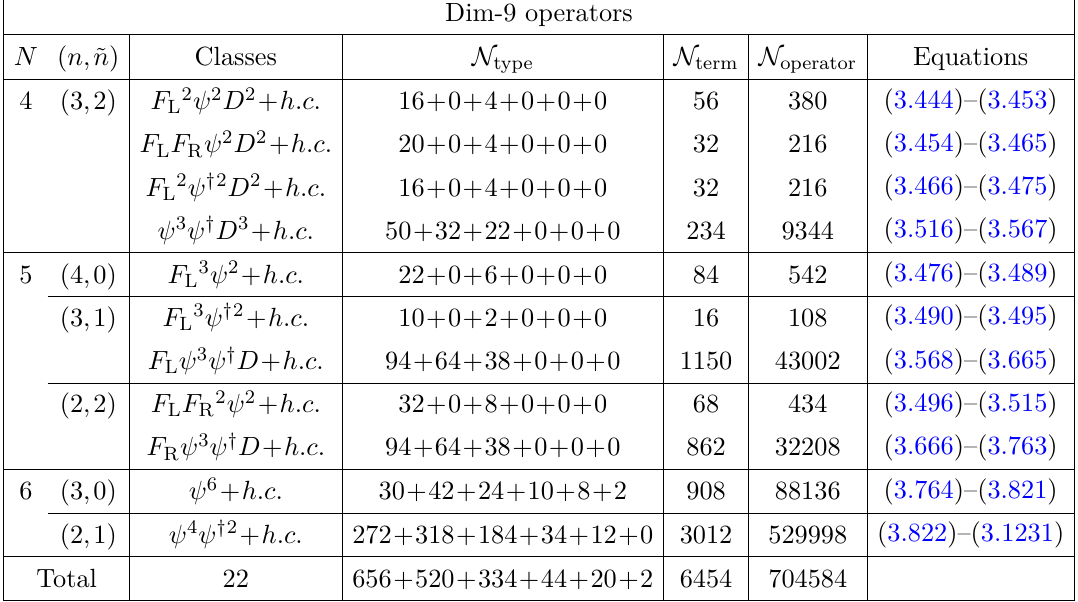
Table 3 . The complete statistics of dimension 9 LEFT operators. The numbers under N type describe the sum of each possible | ∆ L | types/operators with N = N ( | ∆ L | = 0) + N ( | ∆ L |